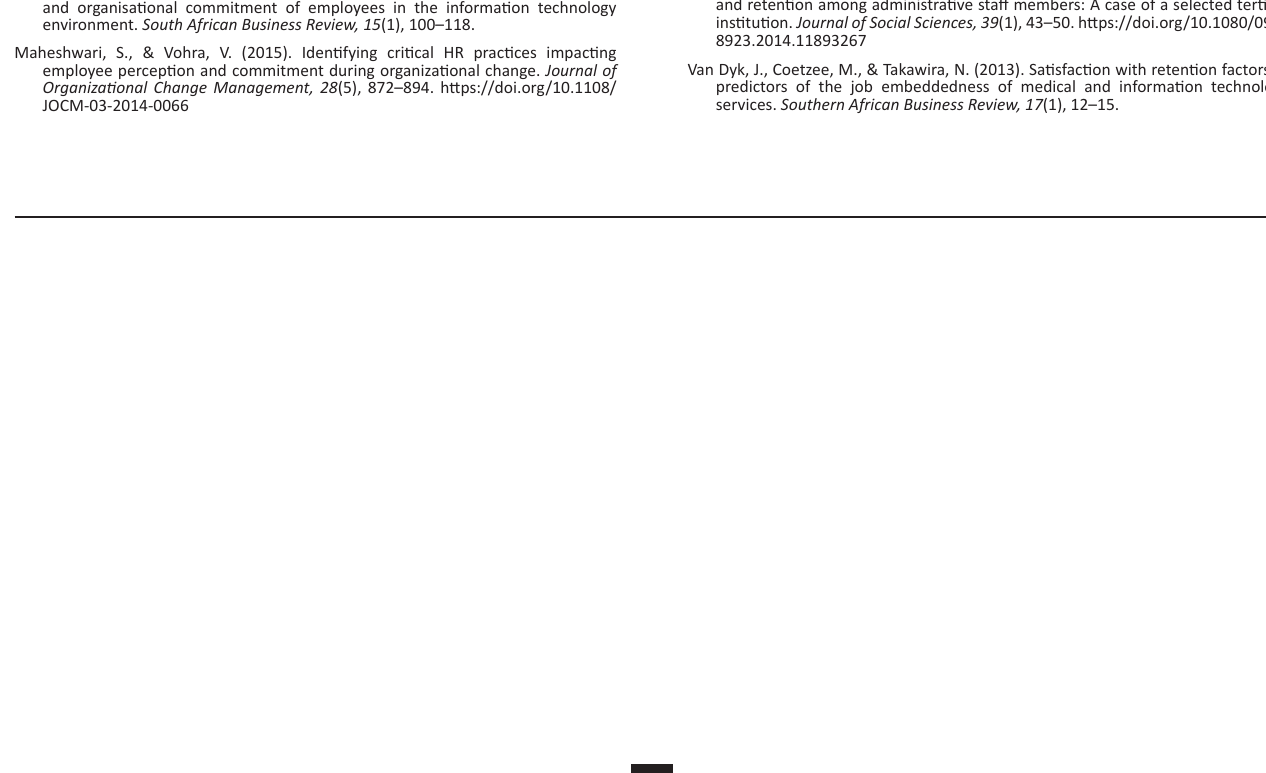
Tabachnick, B., & Fidell, L. (2013) Using multivariate statistics (6th ed.). Upper Saddle River, NJ: Pearson